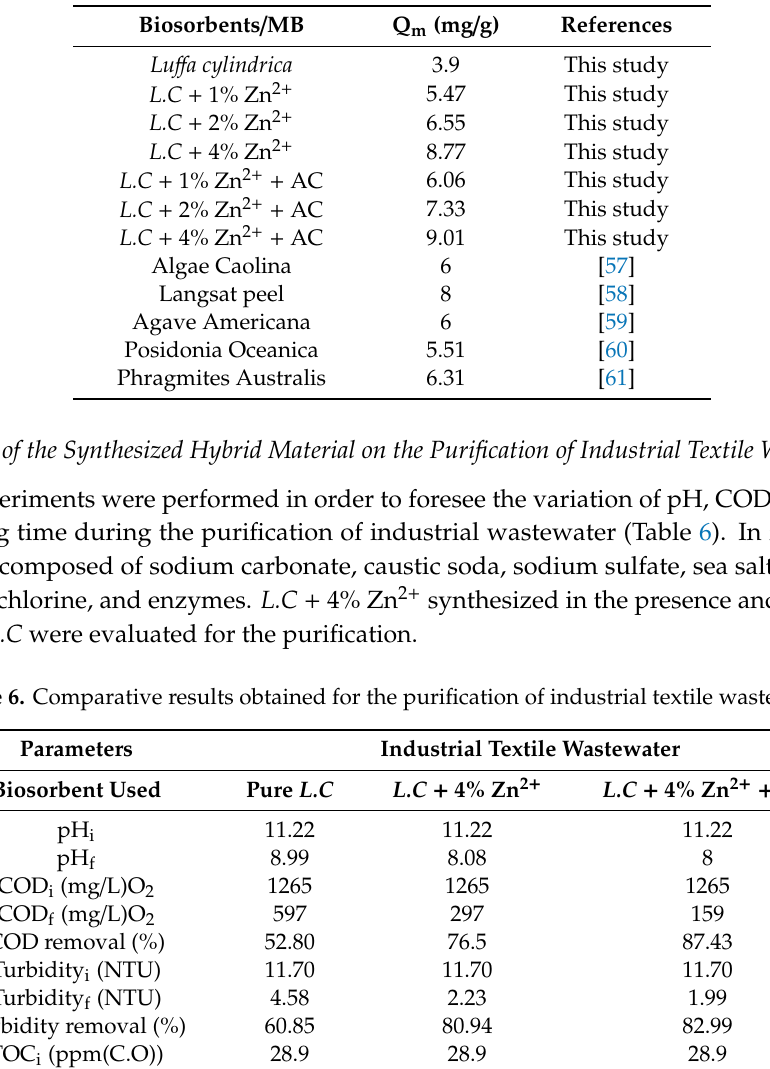
Table 5. Comparison of biosorption characteristics between hybrid material synthesized and other studied biosorbents used for MB biosorption.